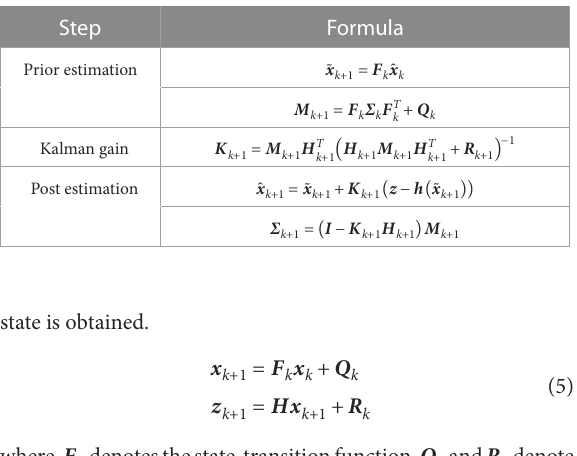
TABLE1 EquationsofEKF. Step Formula